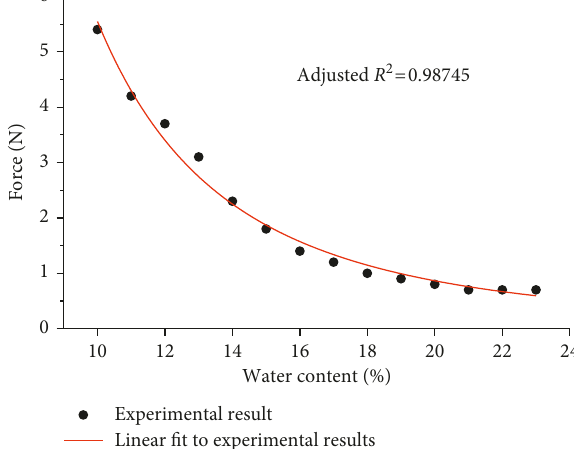
Figure 17: The maximum tensile force at different moisture